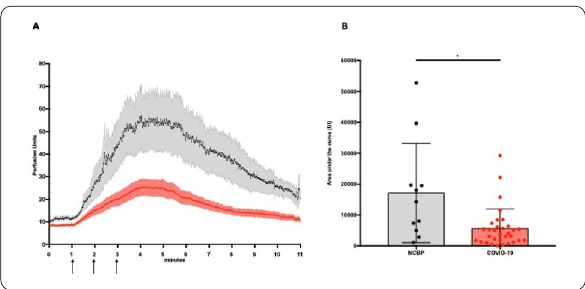
Figure 1. A. Skin microvascular blood flow in response to three stimulation of acetylcholine (arrows) in NCBP patients (grey) and in COVID-19 patients (red), represented as mean / SEM every seconds for 10 min after the first + electric stimulation.